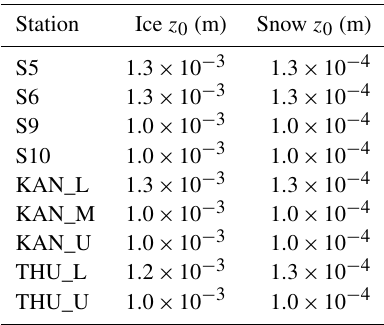
Table 3. The surface roughness length for momentum ( z 0 ) at the nine AWS